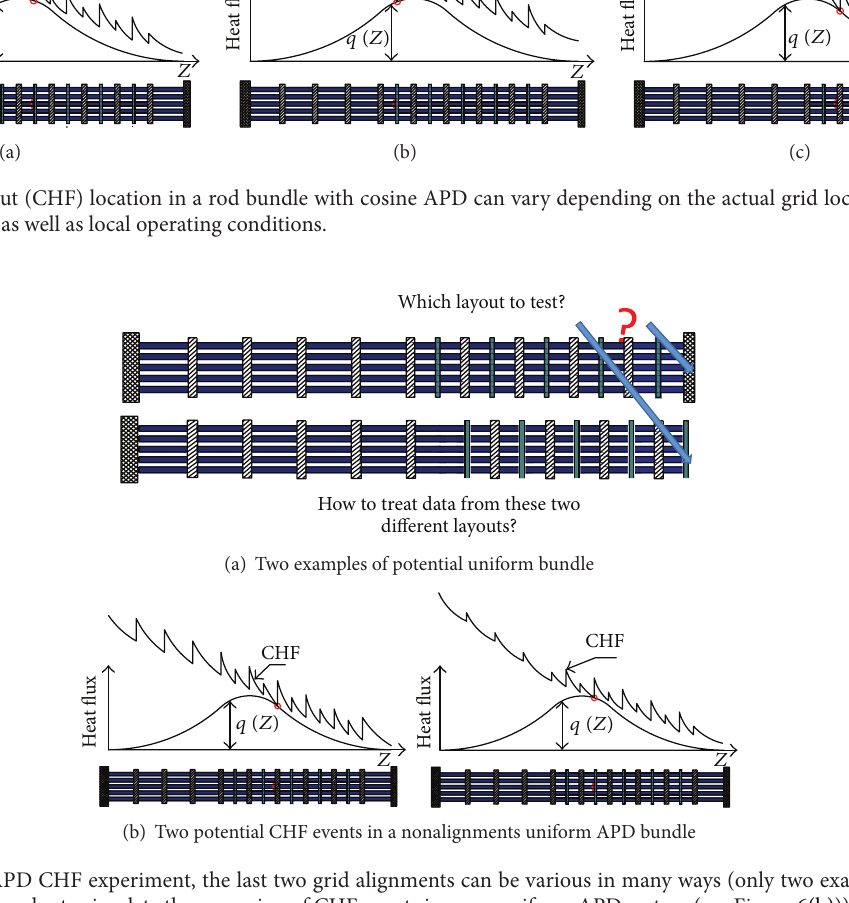
Figure 6: In uniform APD CHF experiment, the last two grid alignments can be various in many ways (only two examples are illustrated here (see Figure 6(a)) in order to simulate the occurring of CHF events in a nonuniform APD system (see Figure